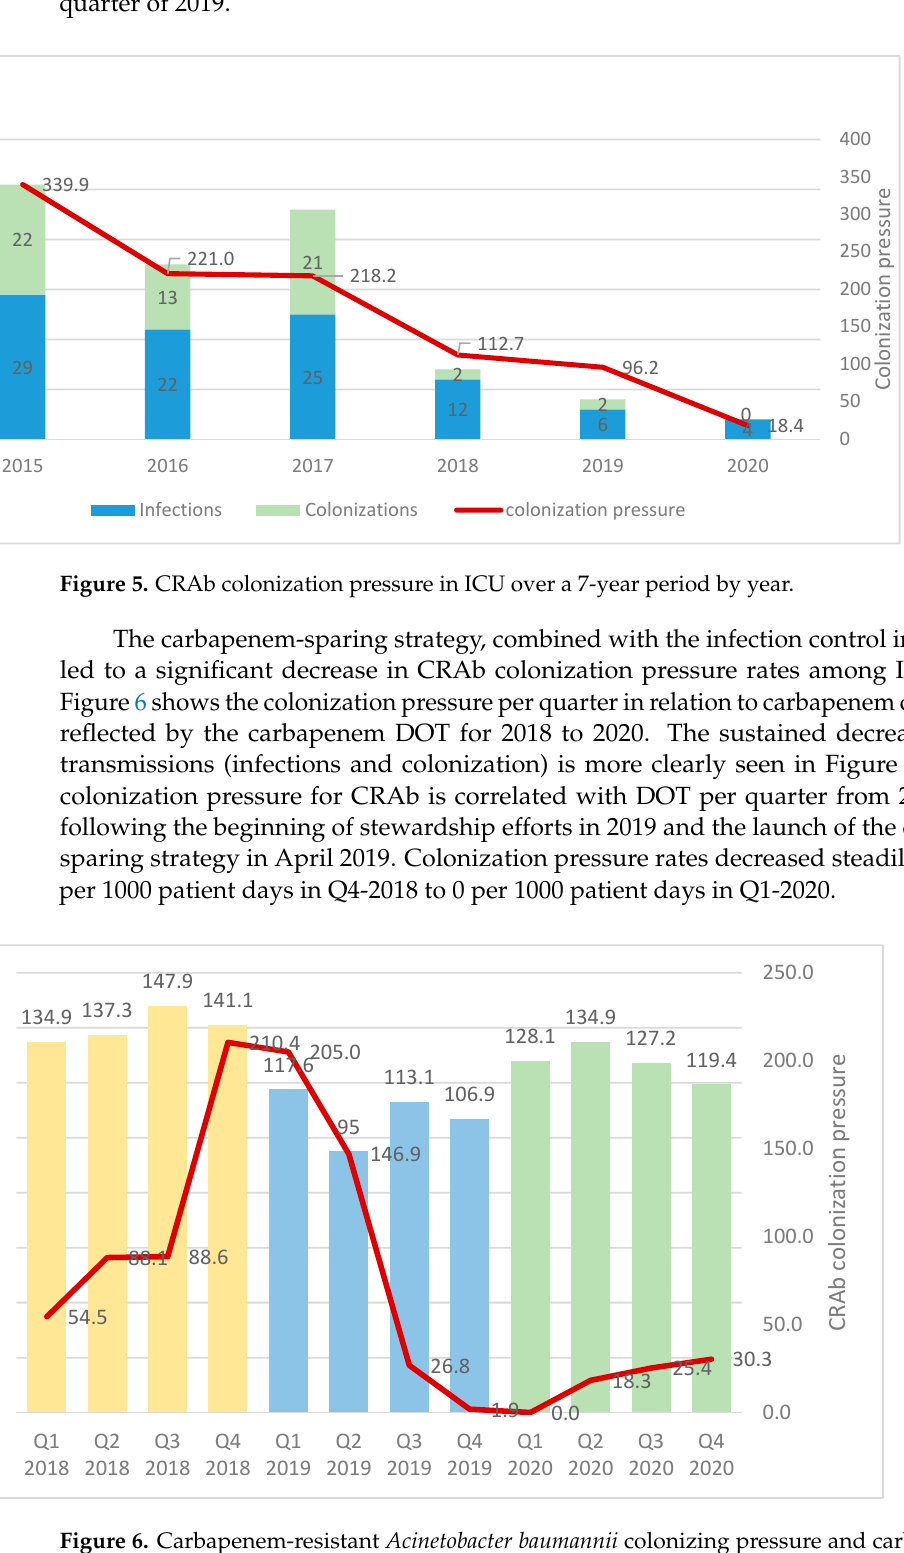
Figure 4. Hand hygiene compliance rates 2016–2020 based on anonymous audits. RN, registered nurse; PN, practical nurse; NST, nurse technician.